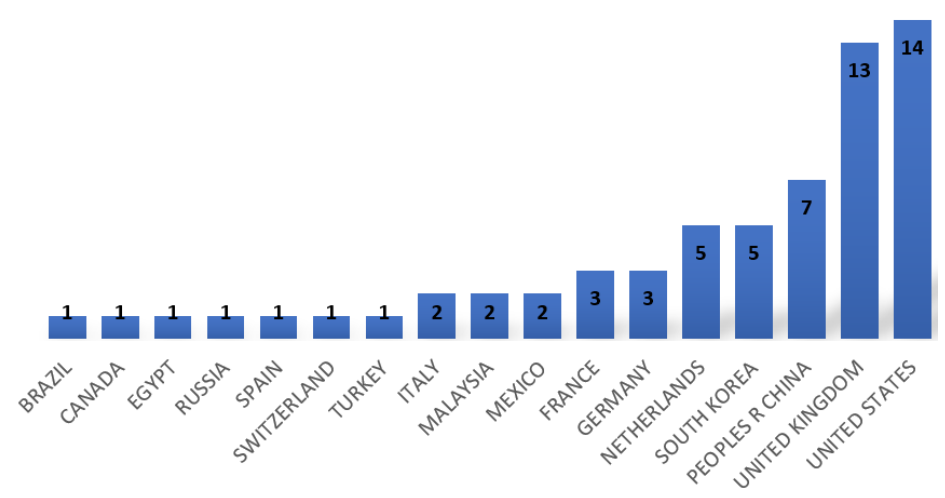
Figure 11. The most productive countries in developing exoskeletons for the knee joint. Table 5. Articles analyzed about knee exoskeletons. Table 5 shows the selected articles, used in the scientometric analysis used, results of the databases and selection criteria.